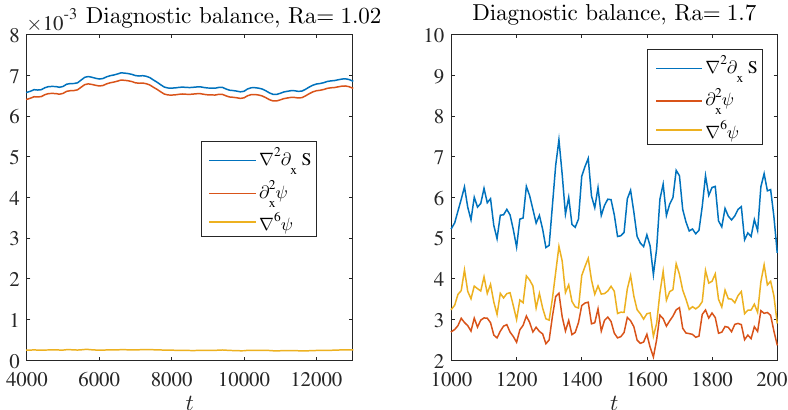
Figure 11. Balances in the diagnostic relation in the statistically steady state with Ra = 1.02, 1.7, respectively. The quantities S t , NL and LI are measured in terms of their r.m.s.